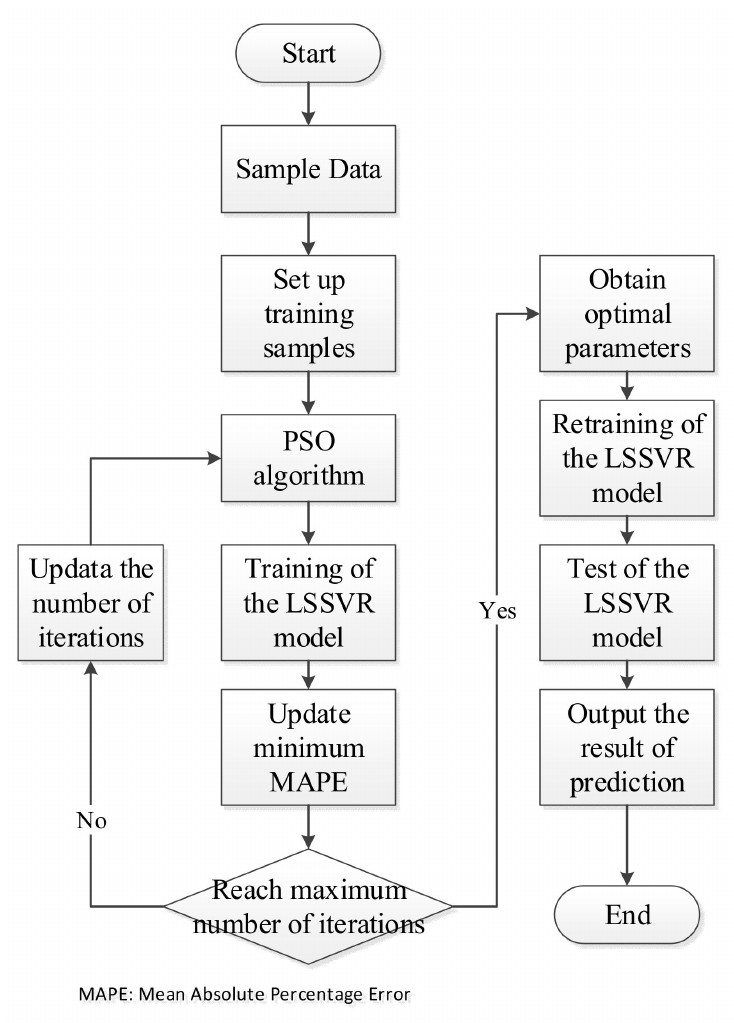
Figure 1. The operation mechanism for the PSO-LSSVR